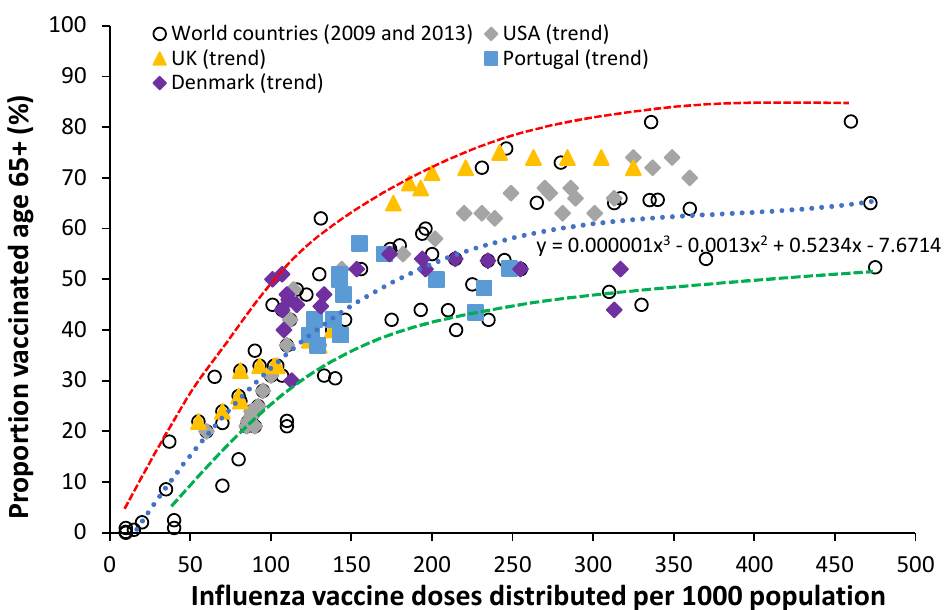
Figure A1. Relationship between influenza vaccine doses distributed and proportion vaccinated in various countries (2009–2013) and the time trend for 4 countries (2000 onward). Red and green dashed lines are the upper and lower limits. The blue dotted line is the line of best fit using a third order polynomial. Before 2000 the bulk of countries lie below 150 doses per 1000 population.